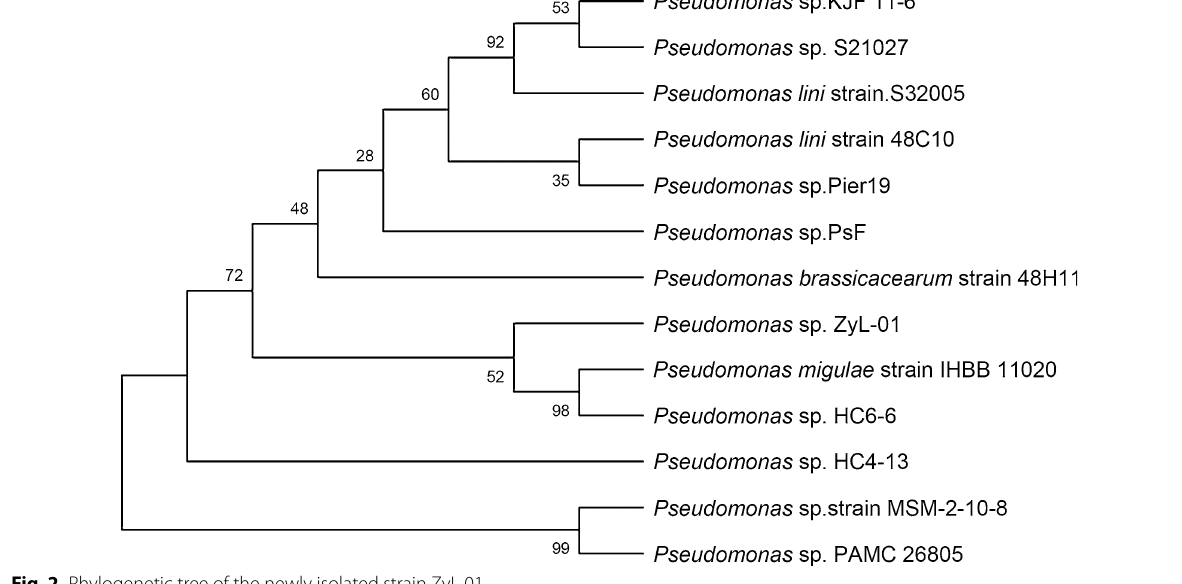
Fig. 2 Phylogenetic tree of the newly isolated strain ZyL-01